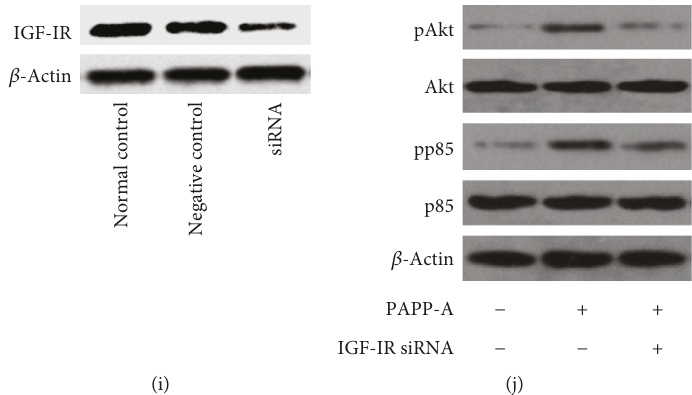
Figure 3: PAPP-A induces the IGF-I/PI3-K/Akt pathway in macrophages. (a, c, e) RAW264.7 macrophages were treated with various concentrations of PAPP-A for 24 h, respectively. (b, d, f) Cells were treated with 5 mg/mL BSA for 24h or with 200ng/mL PAPP-A for di ff erent durations, respectively. (a, b) IGF-I, IGF-IR, and IGFBP-5 mRNA expressions were measured by RT-qPCR. (c, d, e, f) IGF-I, IGF-IR, and IGFBP-5 protein expressions were measured by Western immunoblotting assays. (g, h) Free IGF-I concentrations in the culture medium was estimated with ELISA. (i, j) RAW264.7 macrophages were transfected with control or IGF-IR siRNA and then incubated with PAPP-A (200ng/mL) for 24h. (i) Protein samples were immunoblotted with anti-IGF-IR or anti- β -actin antibodies. (j) Western analysis for phosphorylated Akt and PI3-K p85 subunit. Similar results were obtained in three independent experiments. Data are the mean + SD . ∗ P < 0 05 vs. baseline, ∗∗ P < 0 01 vs. baseline, and ∗∗ P < 0 001 vs.